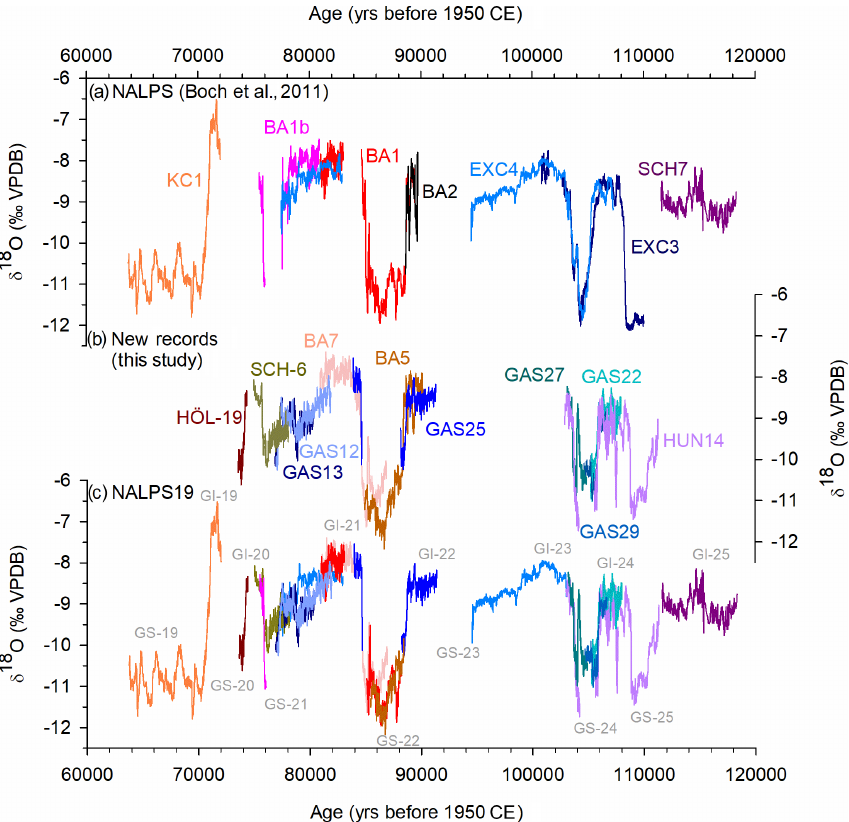
Figure 2. NALPS δ 18 O speleothem records (a) . Original NALPS record of Boch et al. (2011); (b) new records from this study; (c) the most reliable records of Boch et al. (2011) and this study combined to form